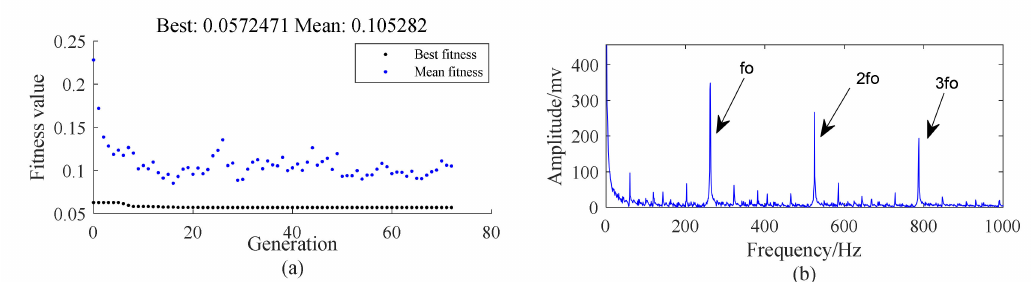
Figure 30. The diagnosis result of the collected signal of the bearing with 3 mm outer race fault processed by the Optimal Wavelet Packet Transform (OWPT): ( a ) the training performance of the OWPT; ( b ) the squared envelope spectrum